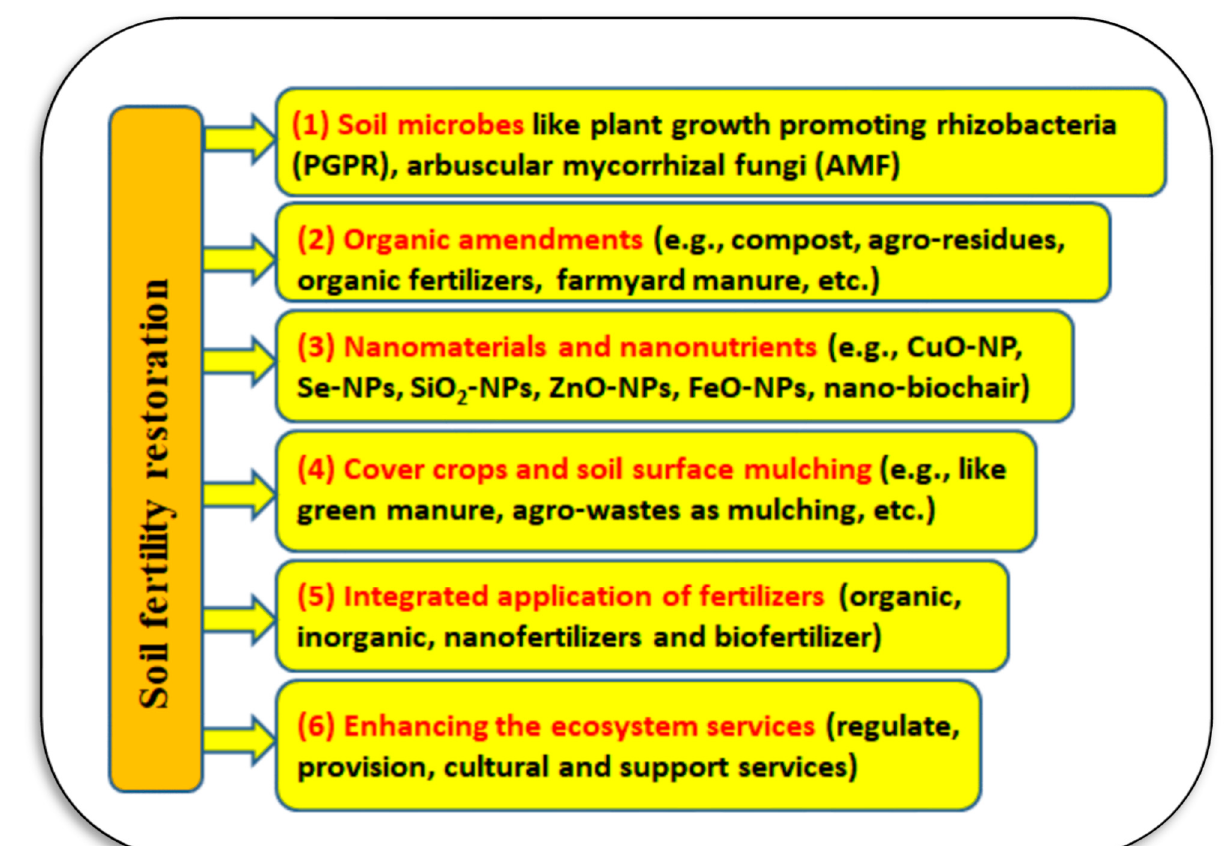
Figure 3. Different applying approaches for soil fertility. Sources: [38,39].